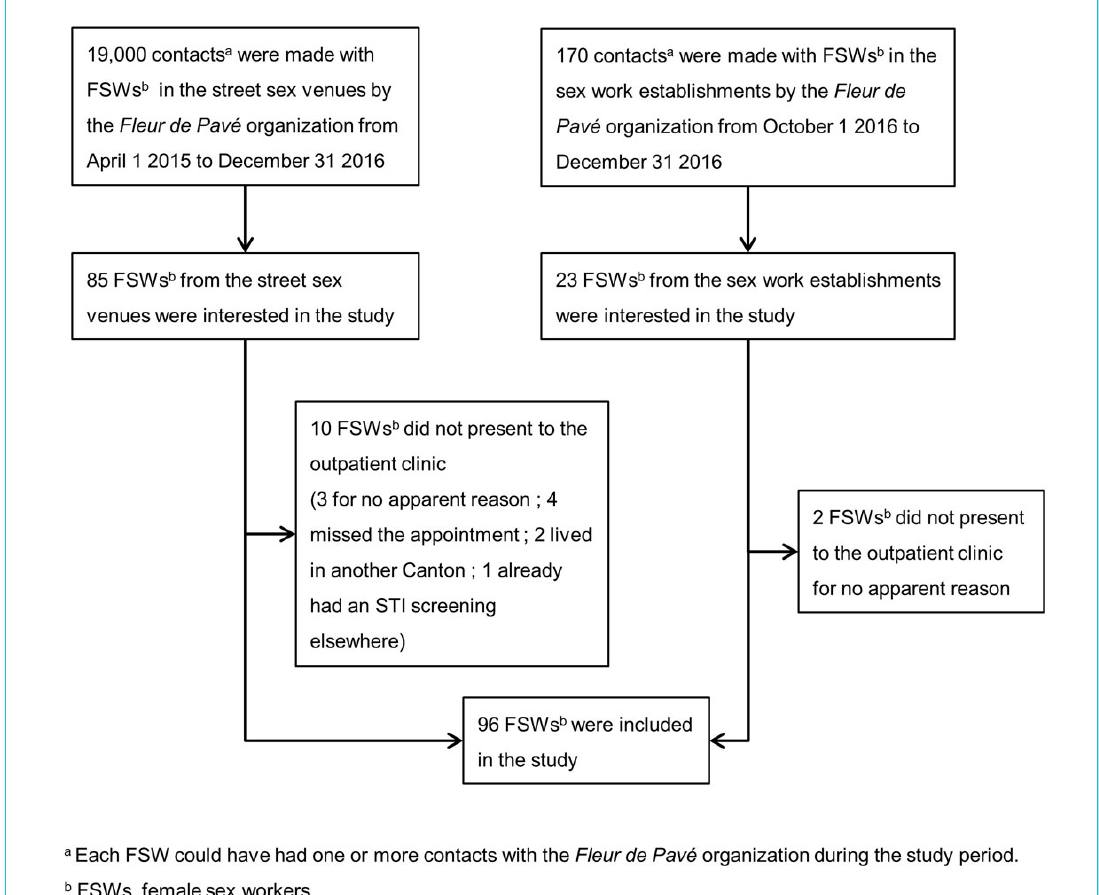
Figure 1: Study flow chart. The study was performed from 1 April 2015 to 31 December 2016 in Lausanne,